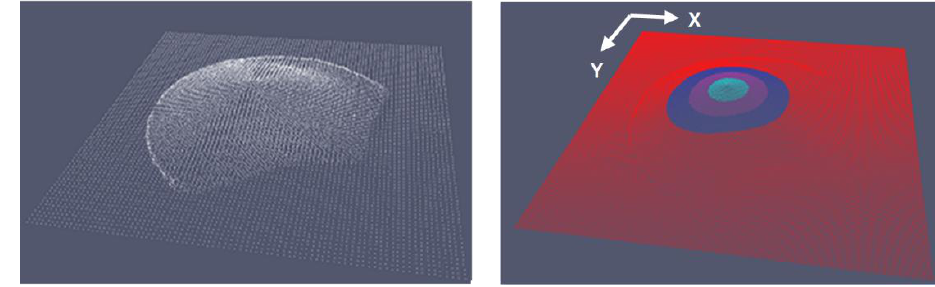
Figure A9. Illustration of the division of the stretched breast into four sections along the z axis. Illustration on Patient 002.